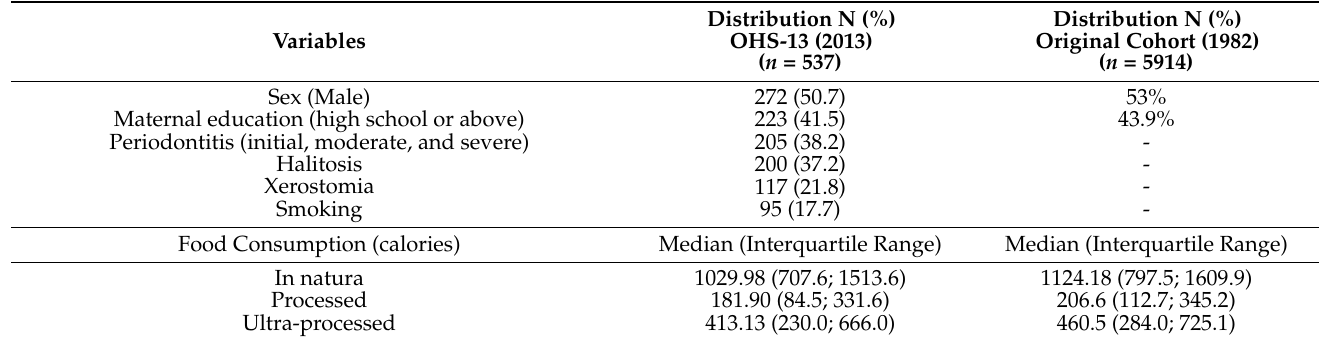
Table 1. Descriptive frequency of the variables used in this study ( n = 537) and comparison between the original cohort population and the participants of OHS-13 (2013).